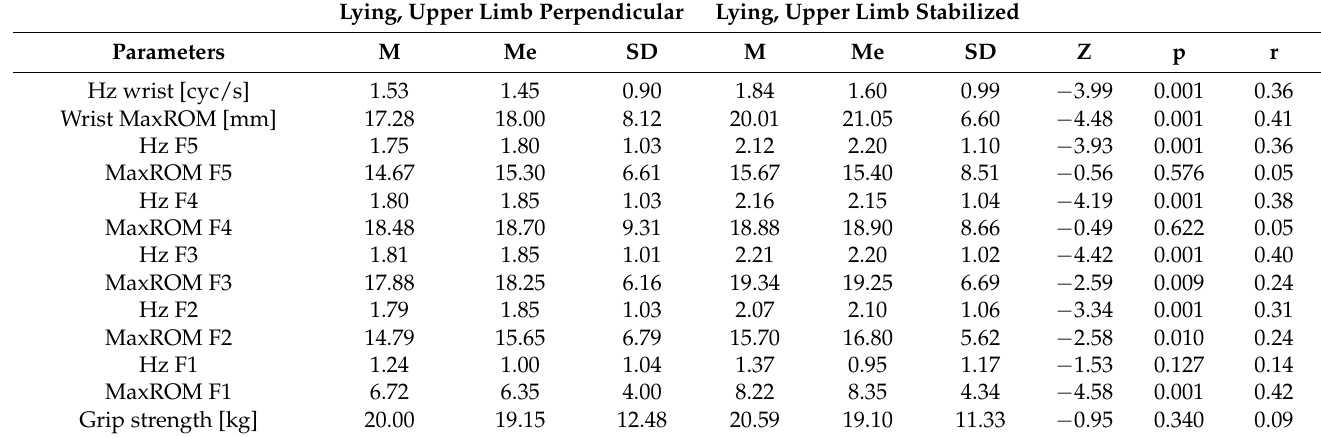
Table 9. Comparison of movement and strength parameters in the lying positions with upper limb and against the body in the group of patients after ischemic stroke. Lying, Upper Limb Perpendicular Lying, Upper Limb Stabilized